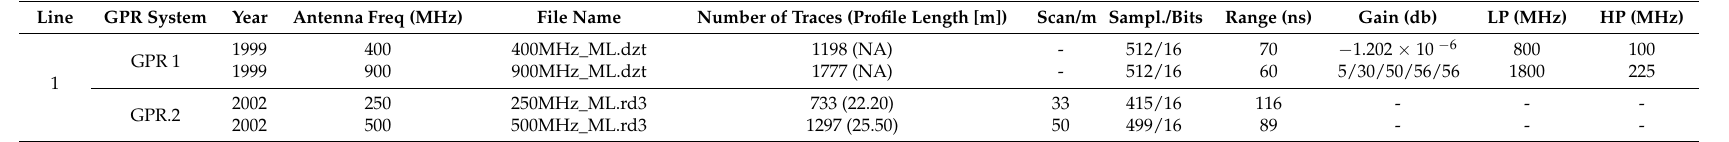
Table 4. Information about data collected in the multilayer. NA means not